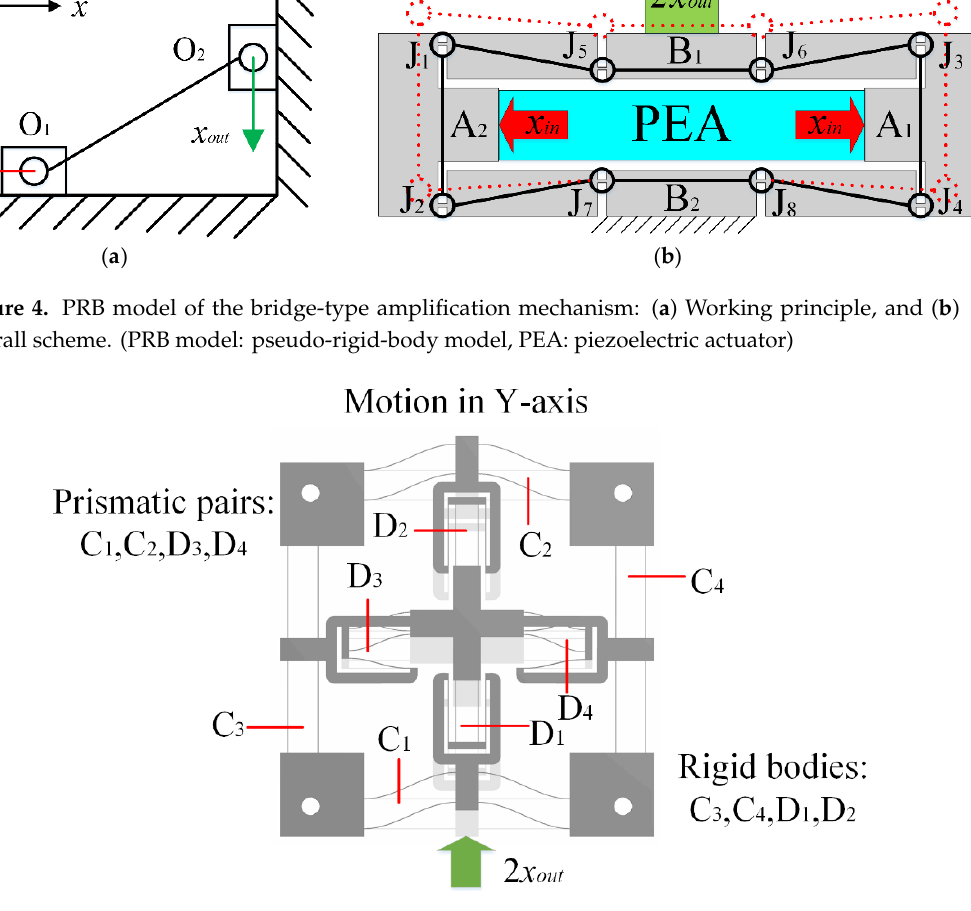
Figure 5. Working principle of parallelogram mechanisms.